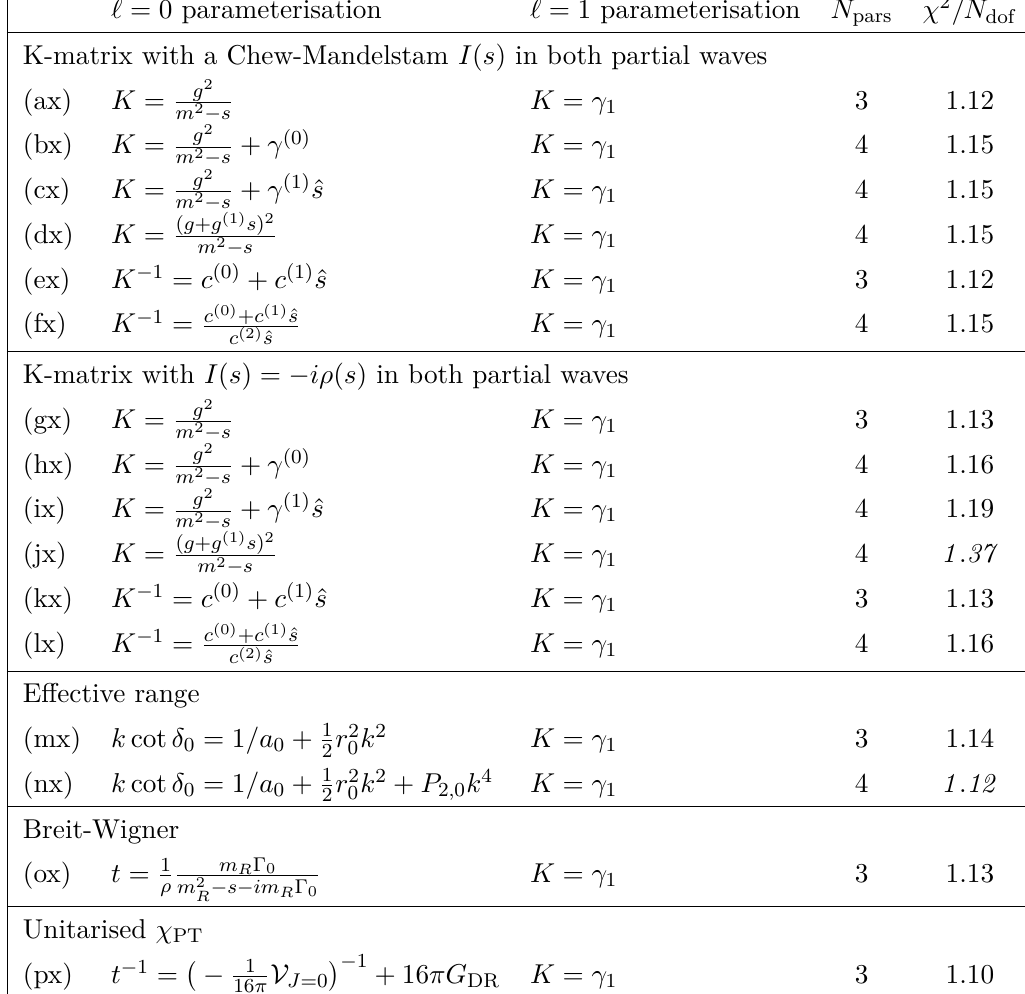
Table 3. The parameterisations used that excluded the deeply-bound level around a t E cm = 0 . 33 . N pars indicates the number of free parameters in each parameterisation. An italicised χ 2 /N dof value indicates this fit was not included in the amplitude figure and pole values due to an additional pole found on the physical